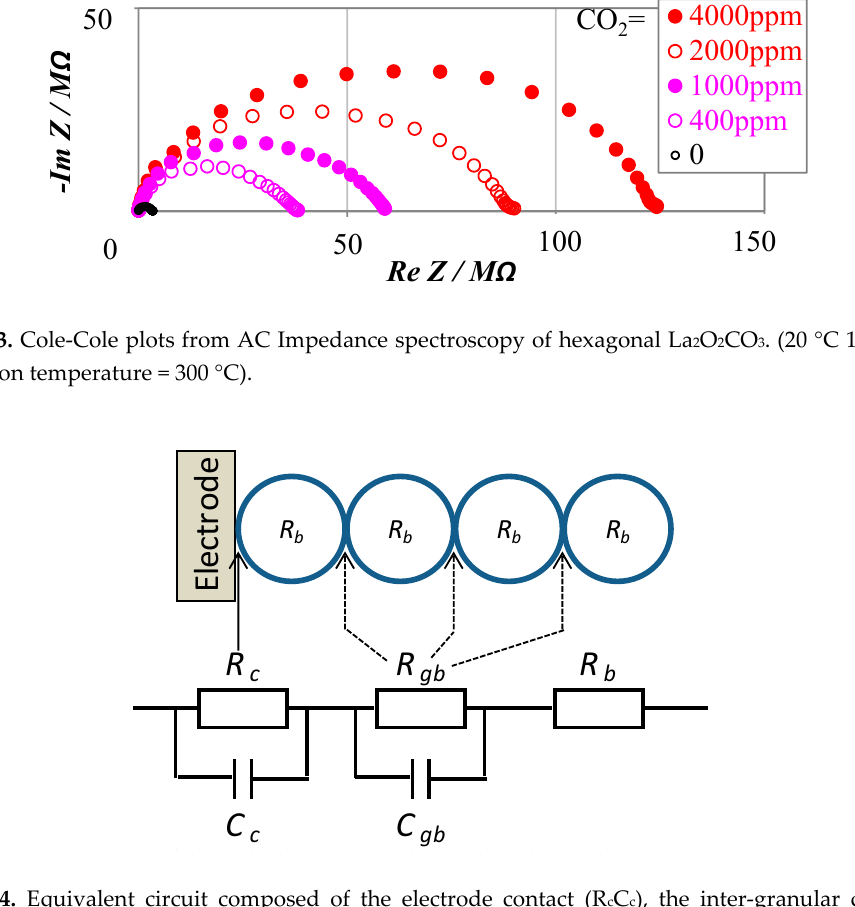
Figure 4. Equivalent circuit composed of the electrode contact (R c C c ), the inter-granular contact (R gb C gb ), and the bulk (R b